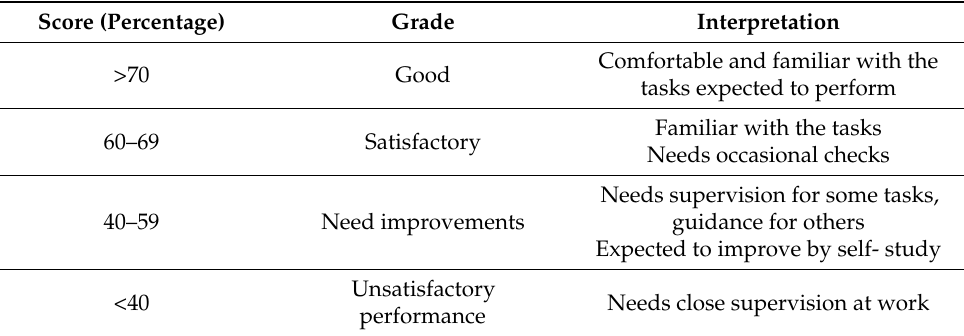
Table 1. Score interpretation and grading of the performance of competency level. Score